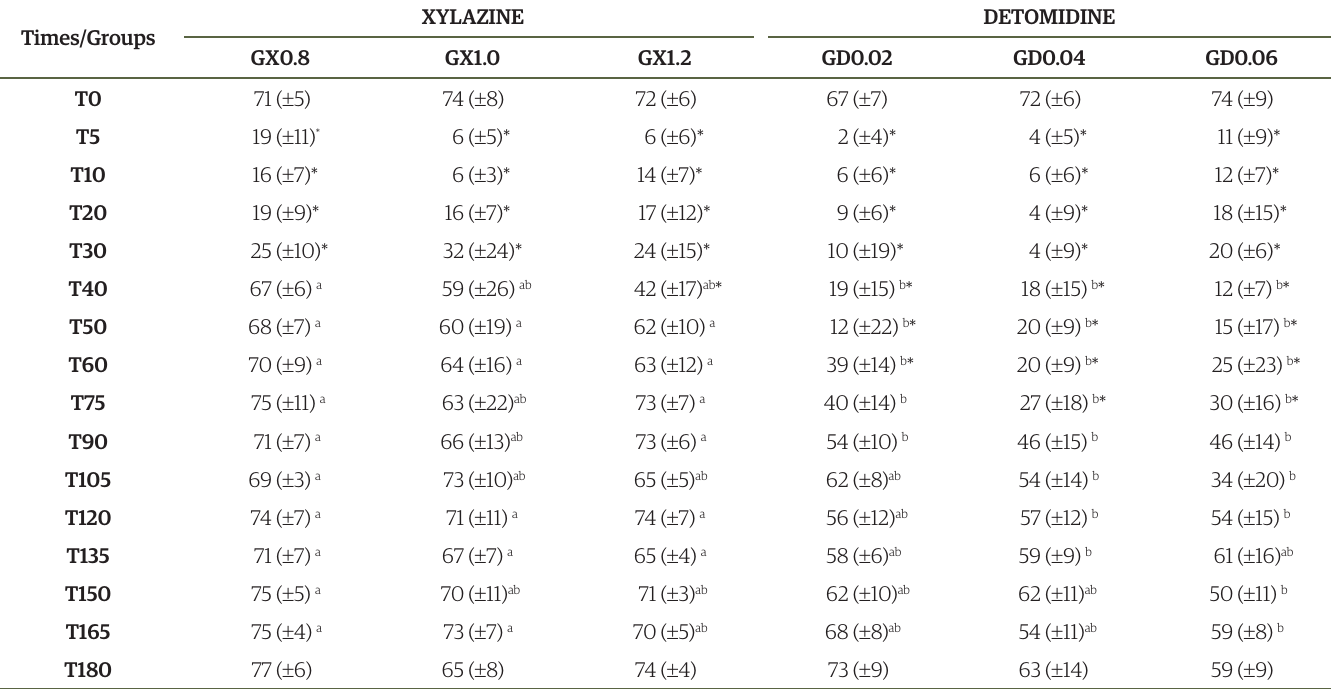
Table 2. Median ( ± Semi-interquartile range) of the nose-ground distance (cm) in donkeys from northeast Brazil sedated with detomidine or xylazine, given intravenously in different